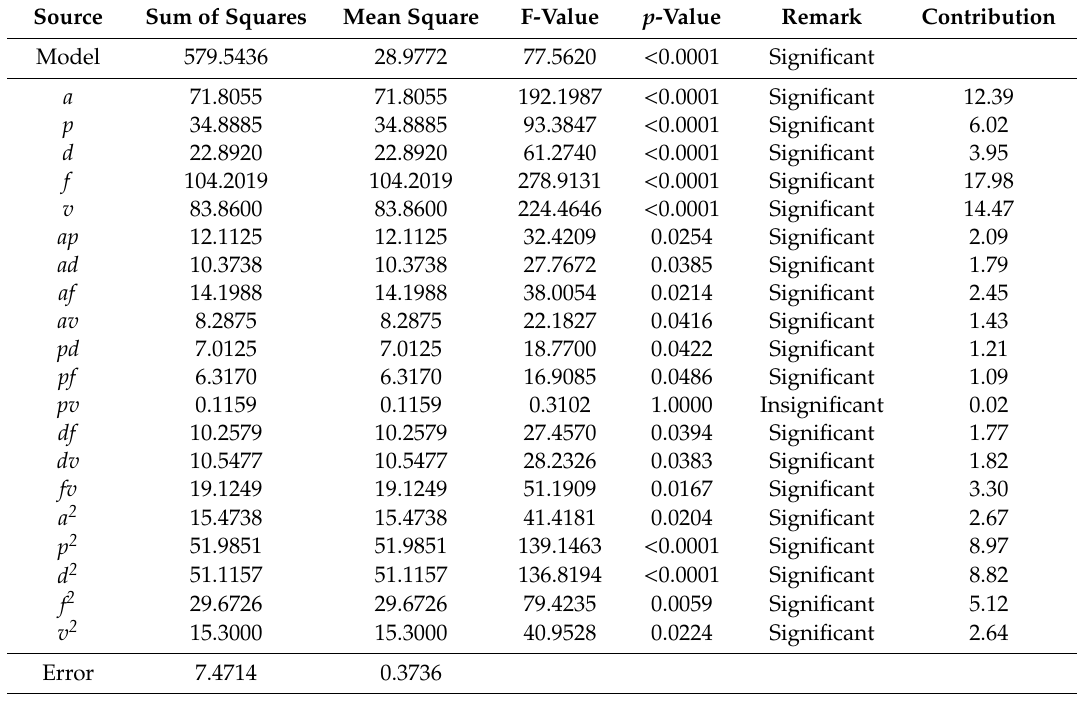
Table 3. Analysis of variance (ANOVA) results for energy efficiency.